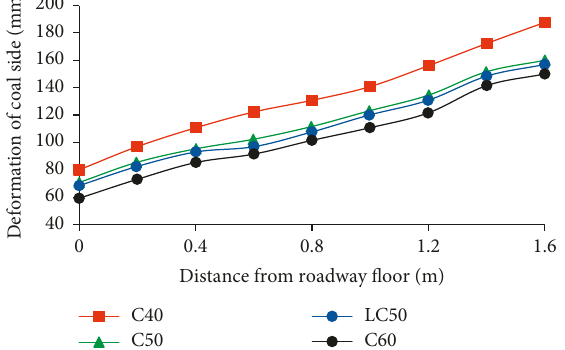
Figure 26: Displacement of the roadway coal side.